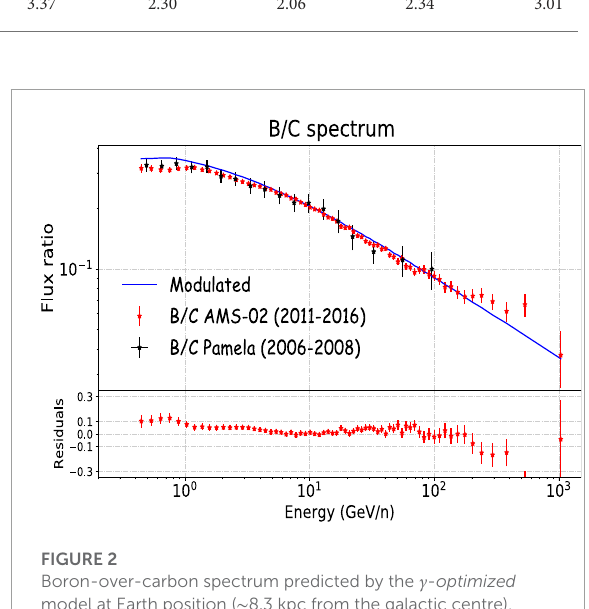
emission at larger energies which we compared with ARGO-YBJ (Bartoli et al., 2015), Tibet AS γ data as well as with LHAASO preliminary results. We showed that those data in combination with Fermi -LAT favor a spatially dependent transport